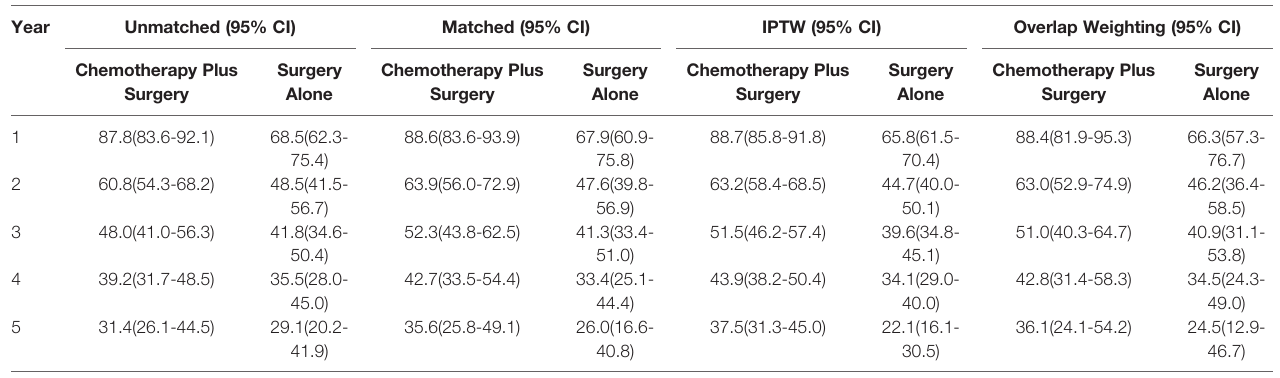
TABLE 2 | Overall survival (%) of SCLC patients receiving chemotherapy plus surgery versus surgery